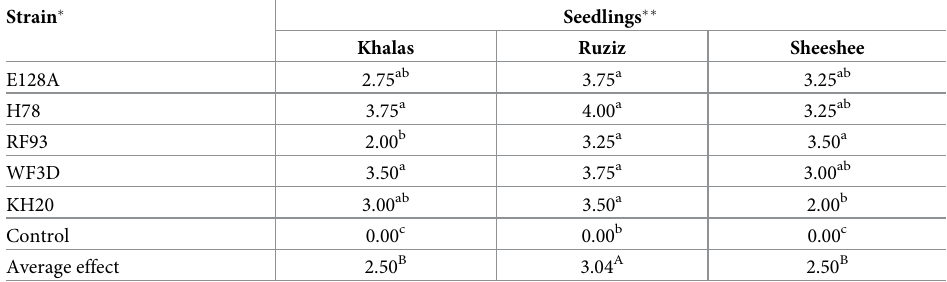
generate any PCR amplicons from other Fusarium spp. The obtained data are in agreement with previous studies on different Fusarium species [13, 23]. For example, Saharan and Naef (2008) used 10 SSR markers developed for F . graminearum to detect genetic diversity of F . oxy- sporum and F . verticillioides , along with F . graminearum isolates, recovered from naturally infected wheat in India and found that not all the F . graminearum SSR markers amplified PCR products from F . oxysporum and F . verticillioides isolates. Moncrief et al. (2016) developed 17 SSR markers to differentiate pathogenic strains of F . proliferatum collected from onion tissues displaying salmon blotch symptoms from other pathogenic strains representing different hosts and countries, as well as from other Fusarium isolates belonging to F . verticillioides , F . thapsi- num , F . subglutinans , F . andiyazi , F . globosum , F . fujikoroi and F . oxysporum . In general, SSR markers are less abundant in fungal genomes compared with other organ- isms’ genomes [24]. Fungal genomes also have unique distribution and occurrence of different Table 4. Re-isolation of five Fusarium strains from aboveground parts of inoculated date palm seedlings derived from seeds of three date palm cultivars. Strain �